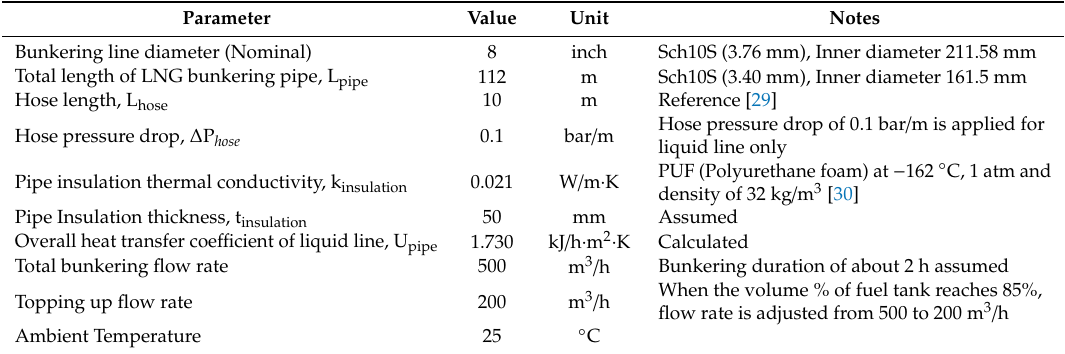
Table 4. Specification of bunkering